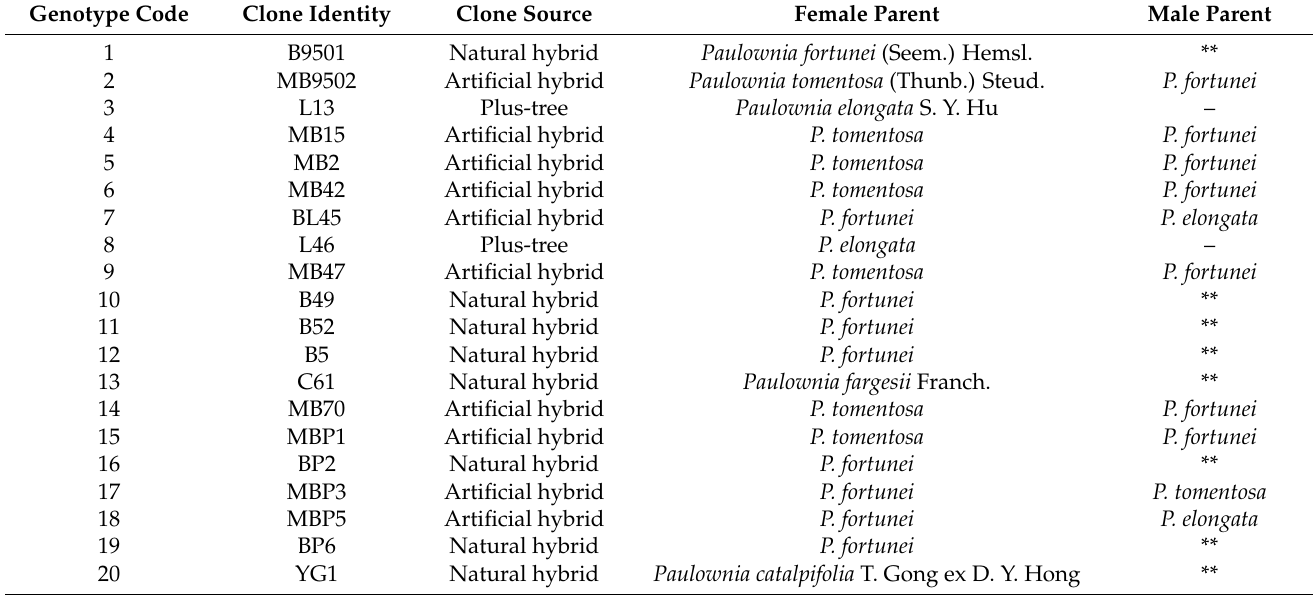
Table 1. Clones included in the trial and their parentage.